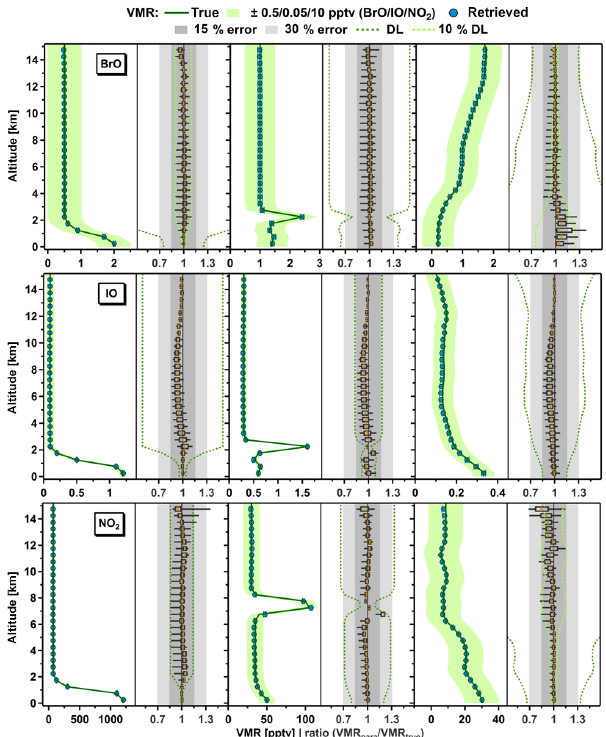
Figure 4. Retrieved VMR for BrO (top), IO (middle) and NO 2 (bot- tom) a, b and c profiles (left to right) using dSCD data simulated for a Rayleigh atmosphere. Individual left panels show VMR para aver- age and standard deviation. Original trace gas profiles are included as reference and green shading denotes individual trace gas VMR error bounds. Right panels display altitude-resolved whisker plots of the ratios of VMR para over VMR true , showing the median (or- ange) and 5, 25, 75 and 95 percentiles. Grey shaded areas indicate 15 and 30% error; green dashed lines show trace gas detection lim-